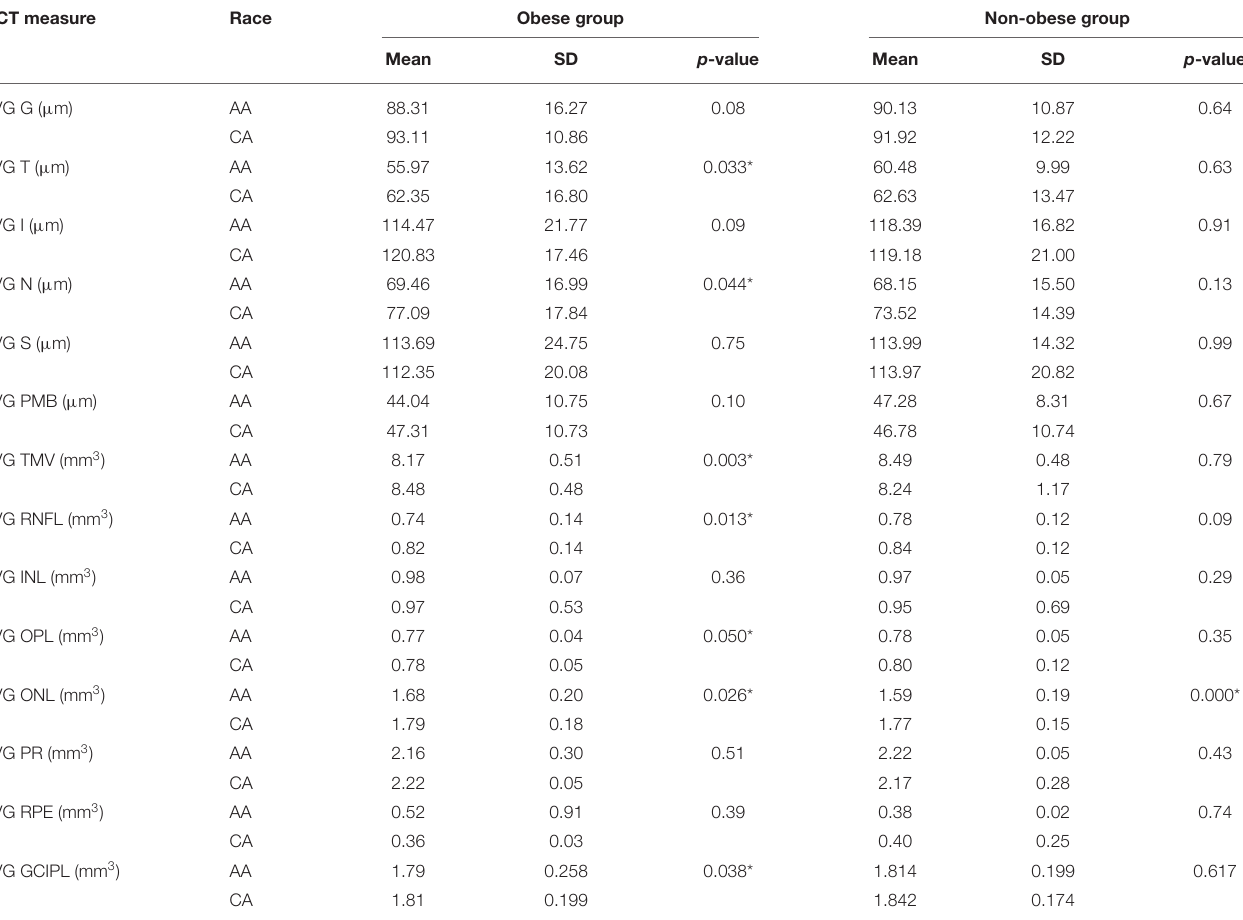
TABLE 4 | BMI category breakdown of OCT measures by race (AA and CA). OCT measure Race Obese group Non-obese